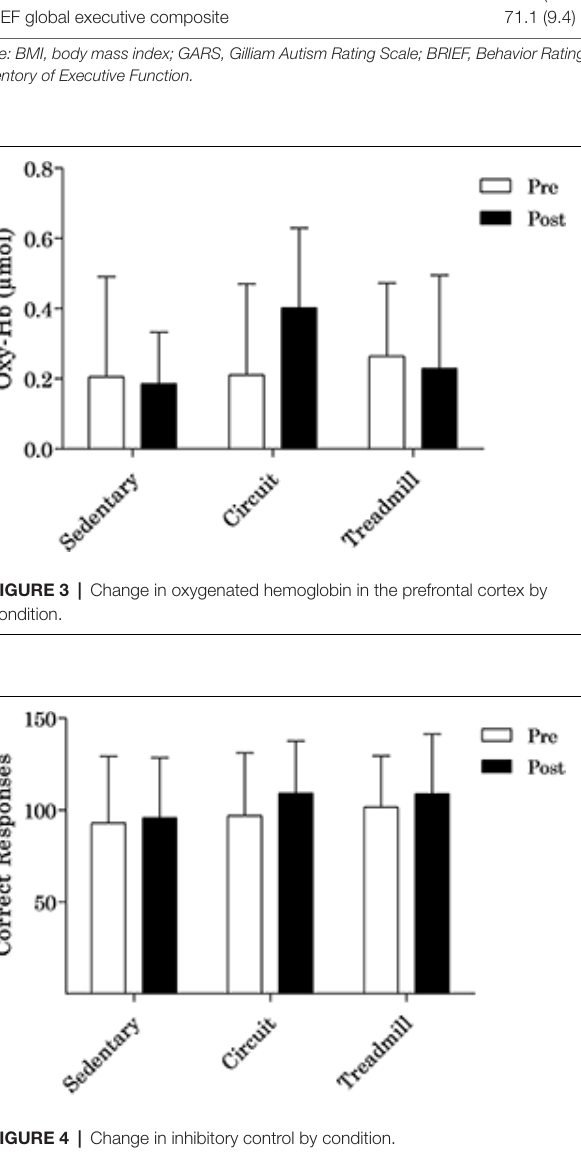
FIGURE 4 | Change in inhibitory control by